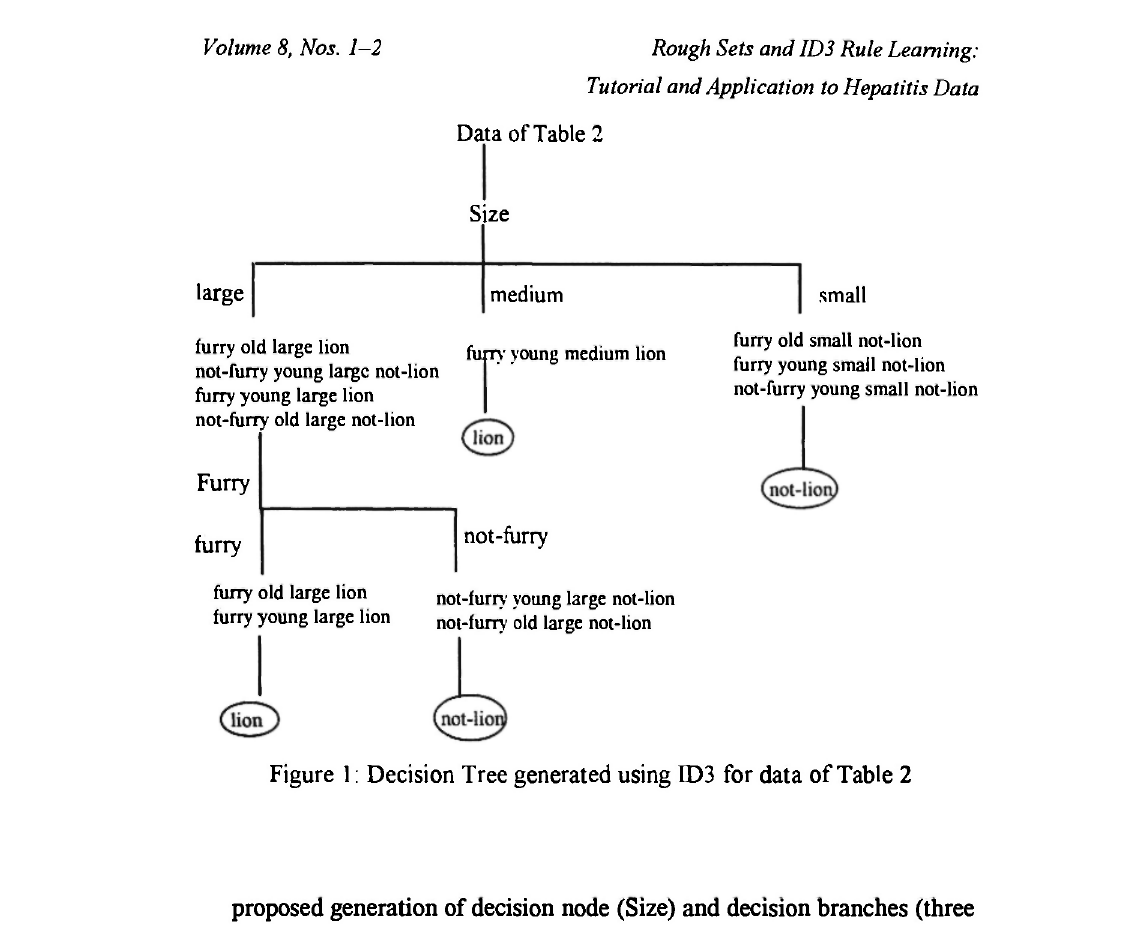
proposed generation of decision node (Size) and decision branches (three in total; large, medium, small). Each decision branch shows the splitting of the objects according to the value of Size. The entropy of Size is calculated using ]£,· w, E, where Wi is defined as the number of objects at the branch / divided by the total number of objects at the parent node; E, is the entropy of each branch and is given by E where pj is defined as the number of objects at branch i which have class j divided by the total number of objects in branch /'. Hence, for branch Marge, medium, small w, is 4/8, 1/8 and 3/8 respectively. The entropy for The total entropy of Size is 4/8*E Similarly, the entropy for attributes Furry and Age are 0.607 and 0.955 respectively. Therefore Size is chosen since it has the lowest